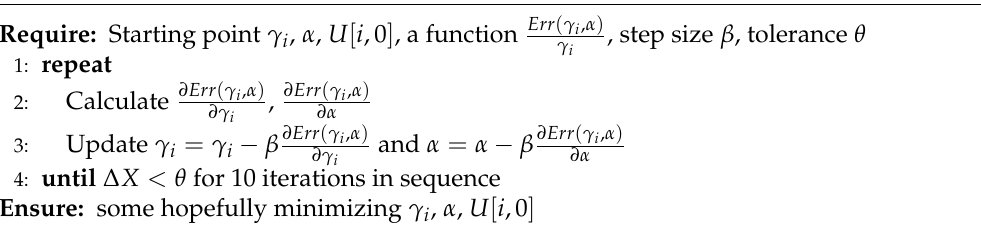
Algorithm 1 Gradient descent.